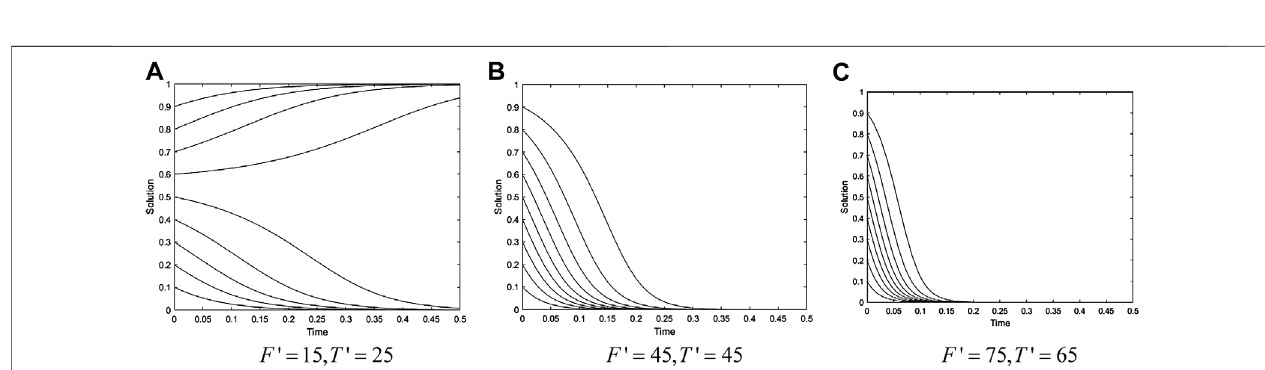
FIGURE4 | Dynamic phase diagram ofthe evolutionarygameunder different values of F ′ and T ′ . (A) F ′ = 15, T ′ = 25; (B) F ′ = 45, T ′ = 45; and (C) F ′ = 75, T ’ = 65.